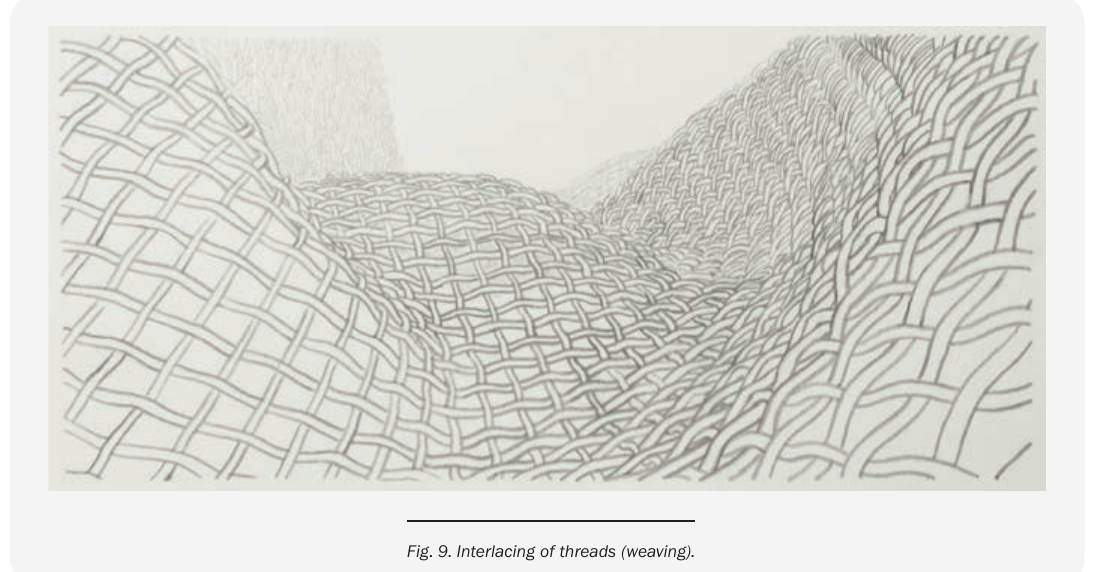
Fig. 9. Interlacing of threads